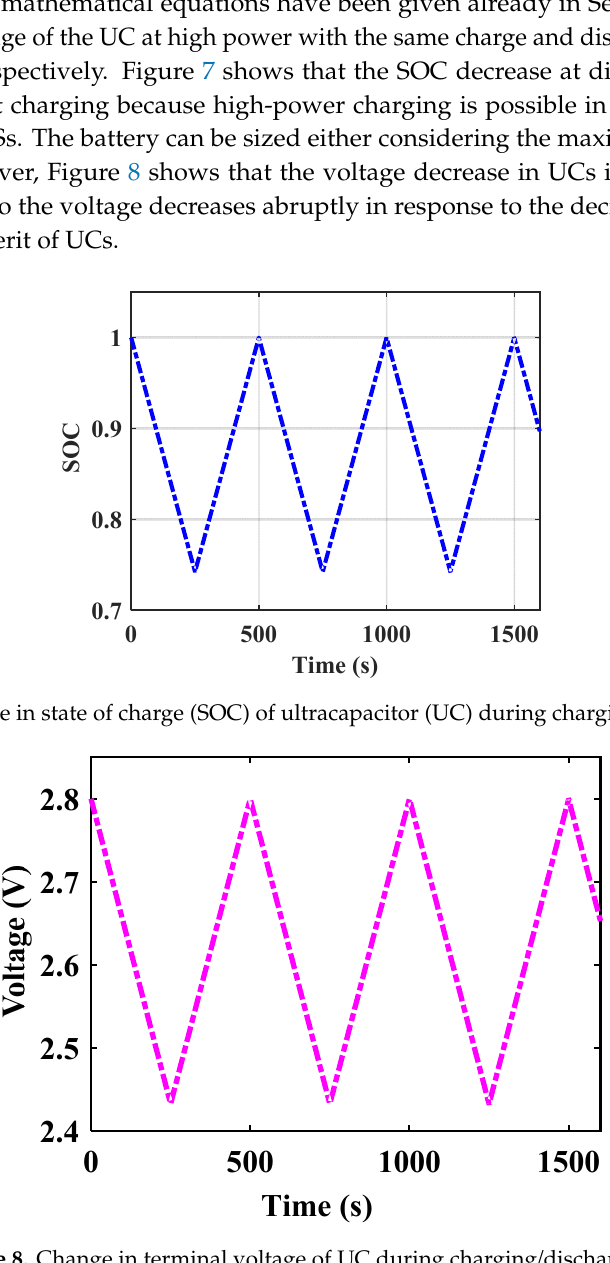
Figure 8. Change in terminal voltage of UC during charging/discharging. 3.4. Battery Modeling In battery modeling, the relation between SOC and open-circuit voltage (OCV) was studied from experimental results. The OCV was calculated for SOC, ranging from 100% to 10% SOC using the